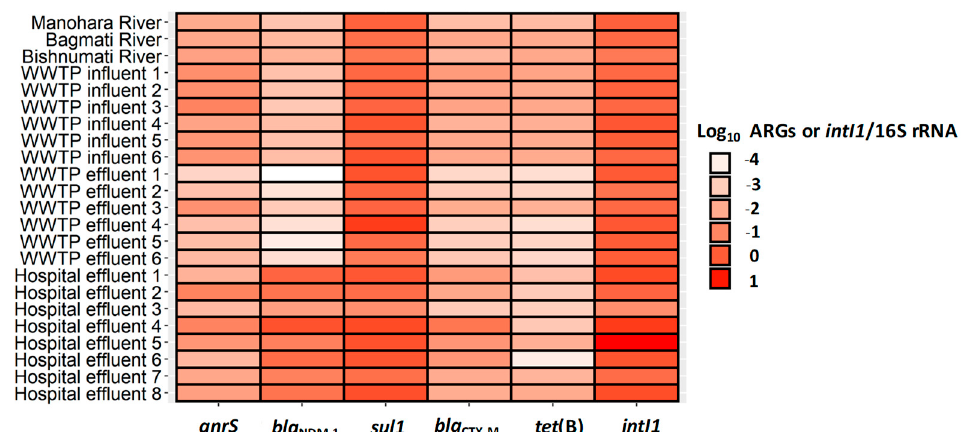
Figure 2. Heat map showing the relative abundance of ARGs and intI1 .